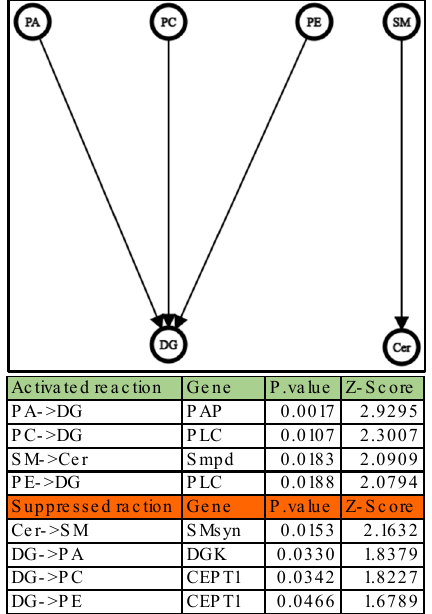
Figure 1. A network graph illustrates the possible transformations of lipid classes in the HbS group compared to WT group, which can be interpreted using known biochemical pathways as a reference. The graph was created with Graph Editor (https://csacademy.com/app/graph_editor/, accessed on 10 January 2023) using a statistical reprocessing of the data produced by LipidOne. The tables below show the activated and suppressed transformations, each with the possible gene involved, the associated p -value and Z-score.